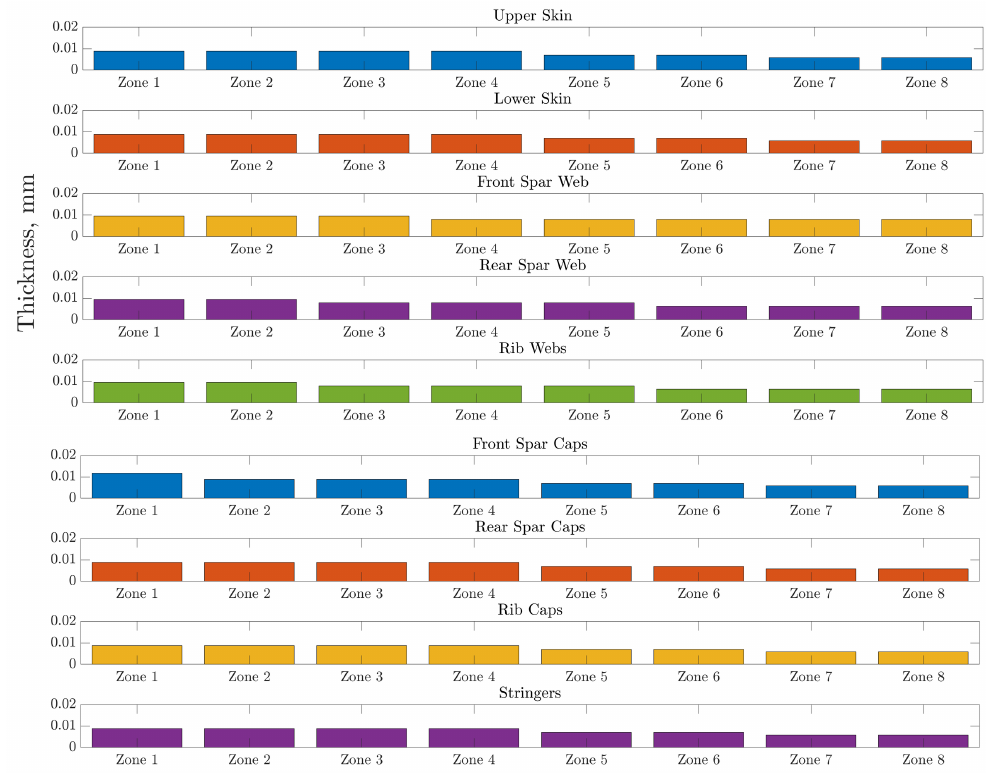
Figure 14. SBO optimal design—spanwise thickness distribution per component.